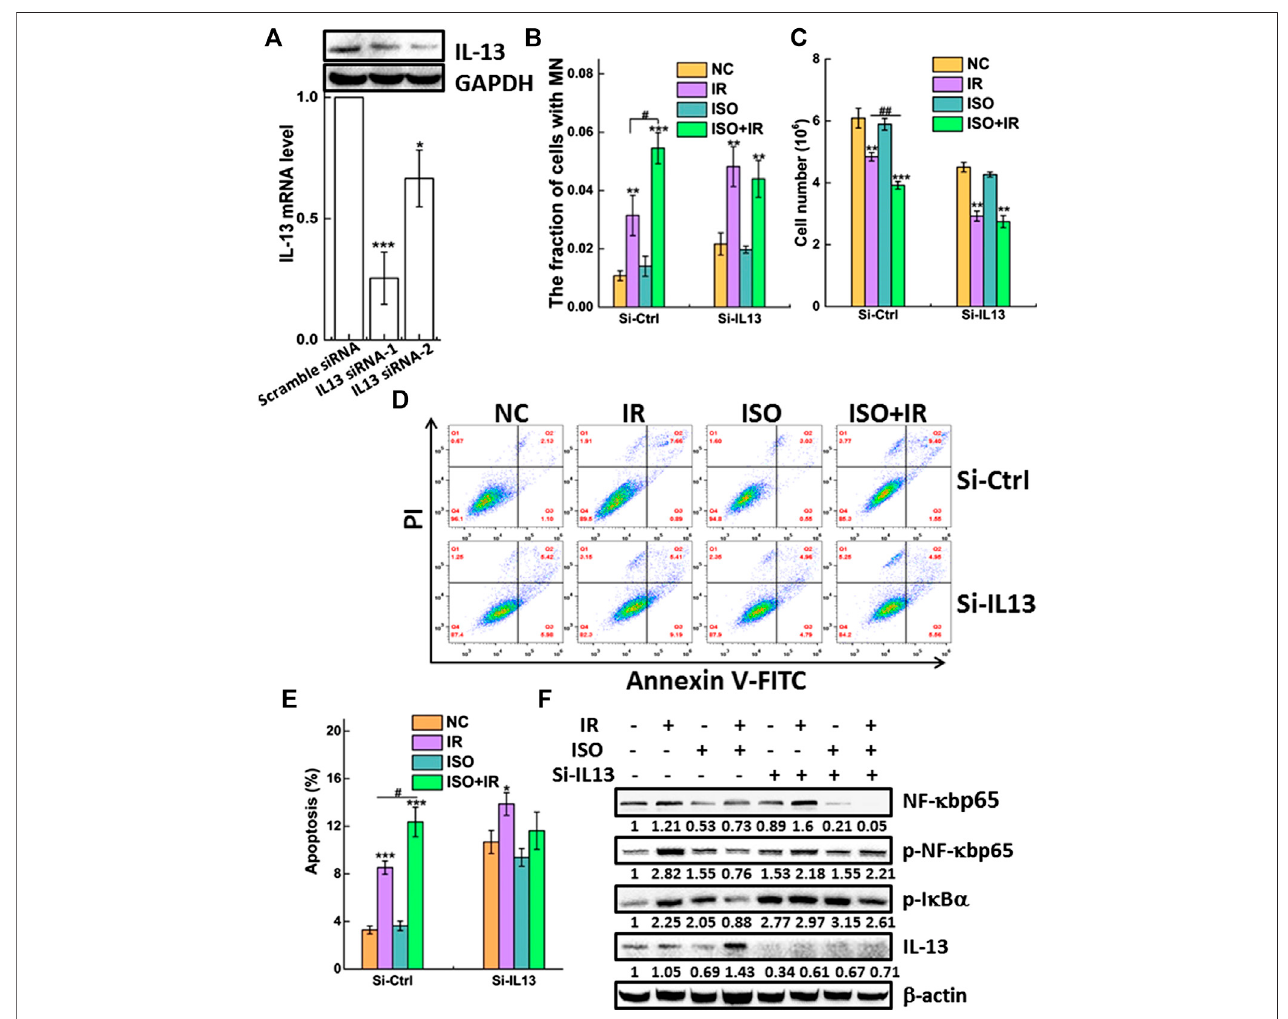
FIGURE 5 | IL-13 is required for the radiosensitivity mediated by ISO. (A) A549 cells were transiently transfected with IL-13 siRNA or scramble-siRNA as a control. Forty-eight hours after transfection the knockdown ef fi ciency of IL-13 in cells was con fi rmed by western blot and qRT-PCR assays. Knockdown of IL-13 disturbed radiosensitivity mediated by ISO indicated in si-Ctrl or si-IL13 groups by micronucleus (B) , cell growth (C), and apoptosis assays (D , E) . (F) The expression of phosphorylated and total NF- κ Bp65 and p-I κ B α , as well as IL-13 and β -actin, was assessed in negative vector or IL-13 silenced A549 cells by western blotting,